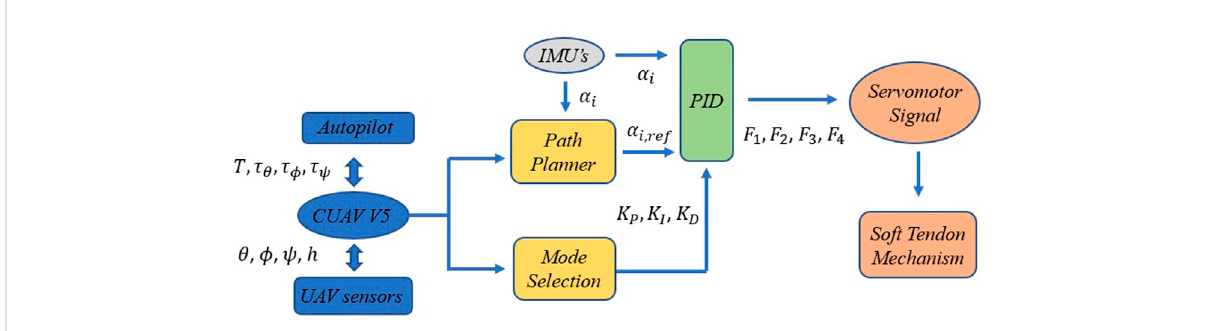
FIGURE 6 Descriptivediagramofthecompensationsystem ’ soperatingalgorithm,includingthepathplanner,modeselectionandPIDcontrollermodules.